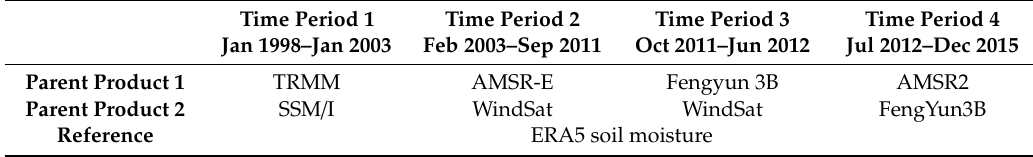
Table 2. Time Periods for the merging of the di ff erent